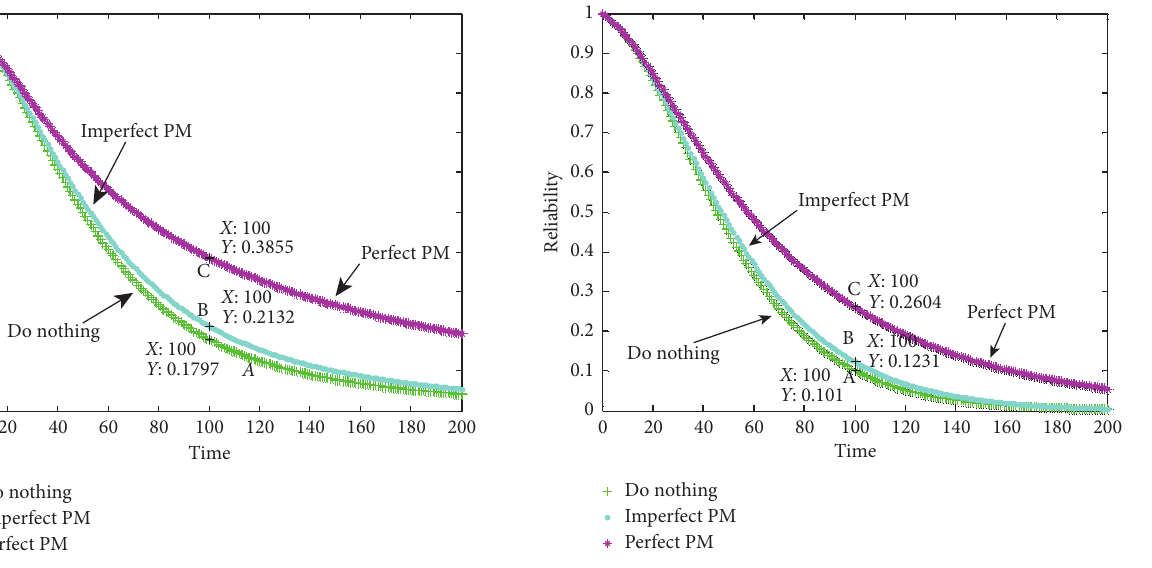
Figure 8: The comparison of three actions on A ( t ) .